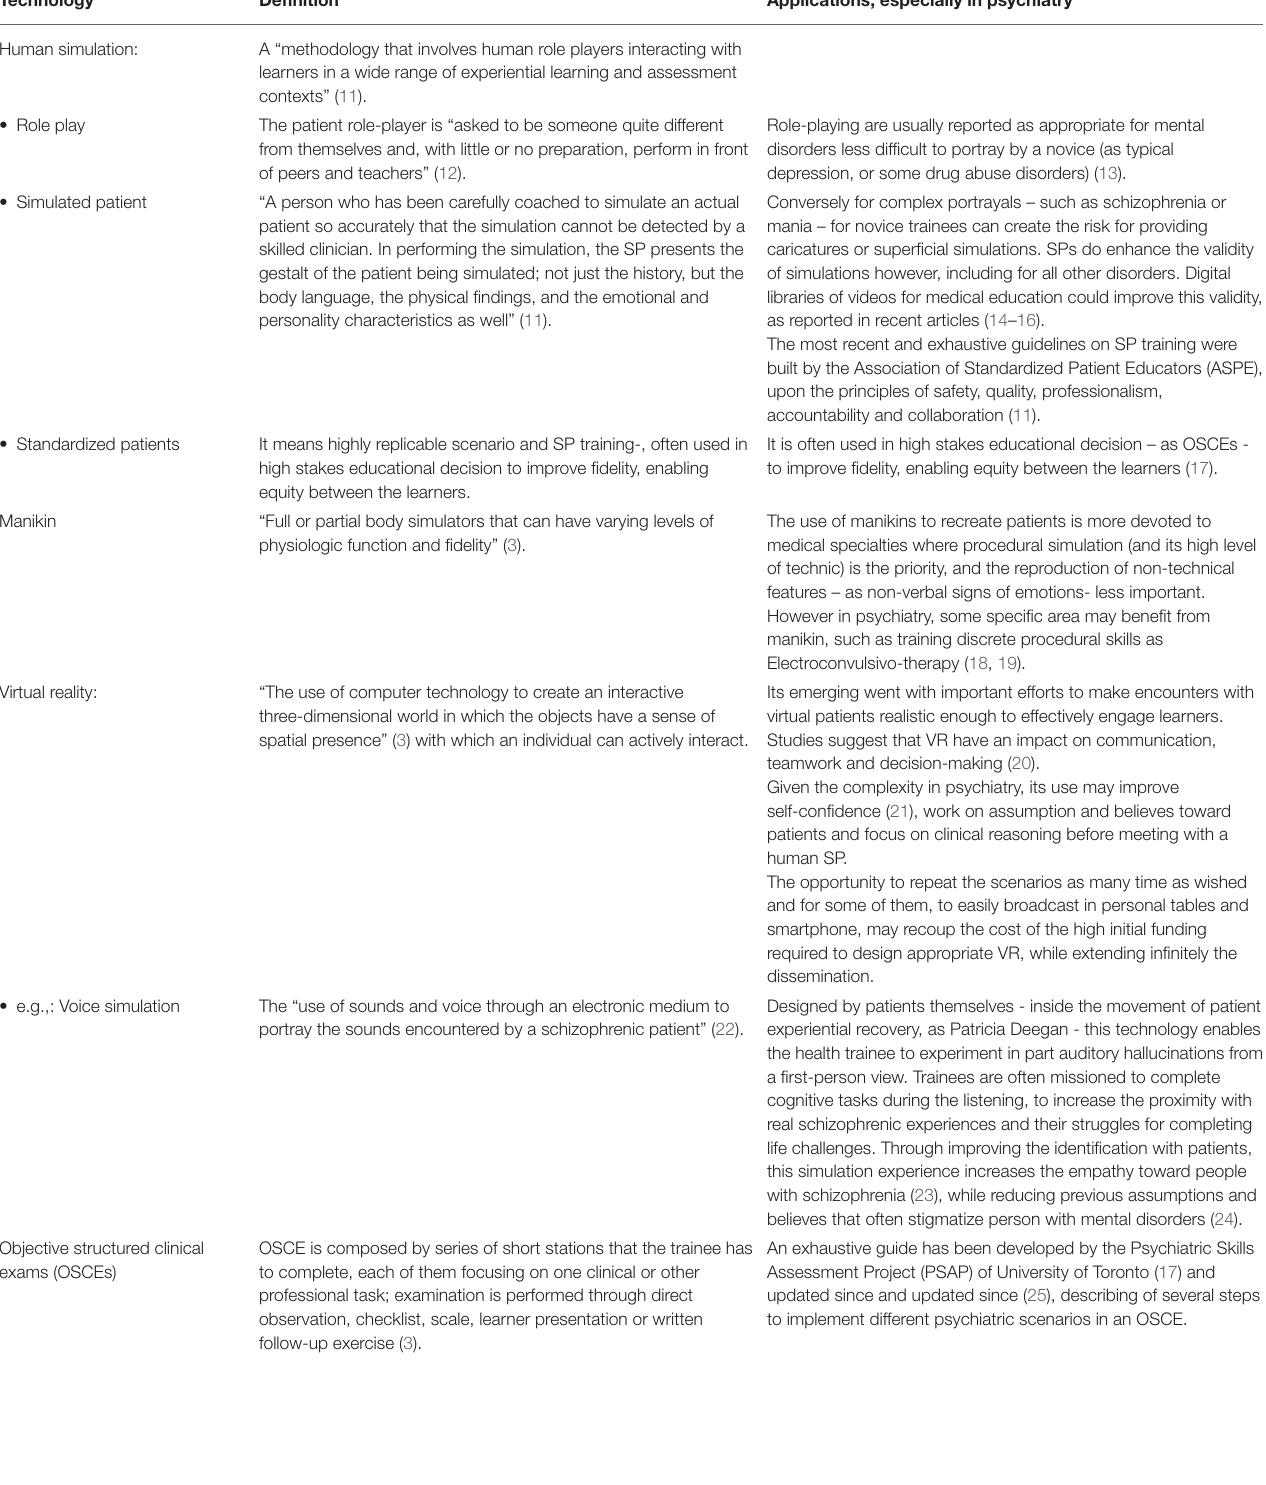
TABLE 1 | Simulation